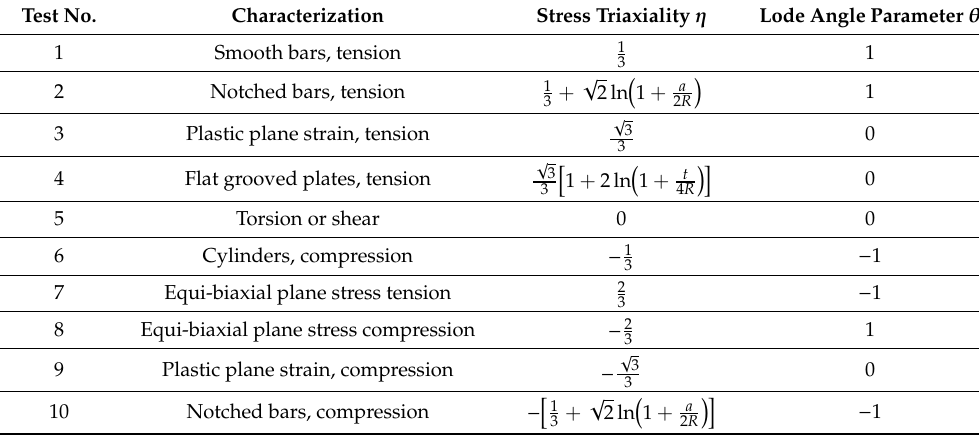
Table 2. A presentation of the classic tests used for calibrating the damage function, developed by Wierzbicki et al.